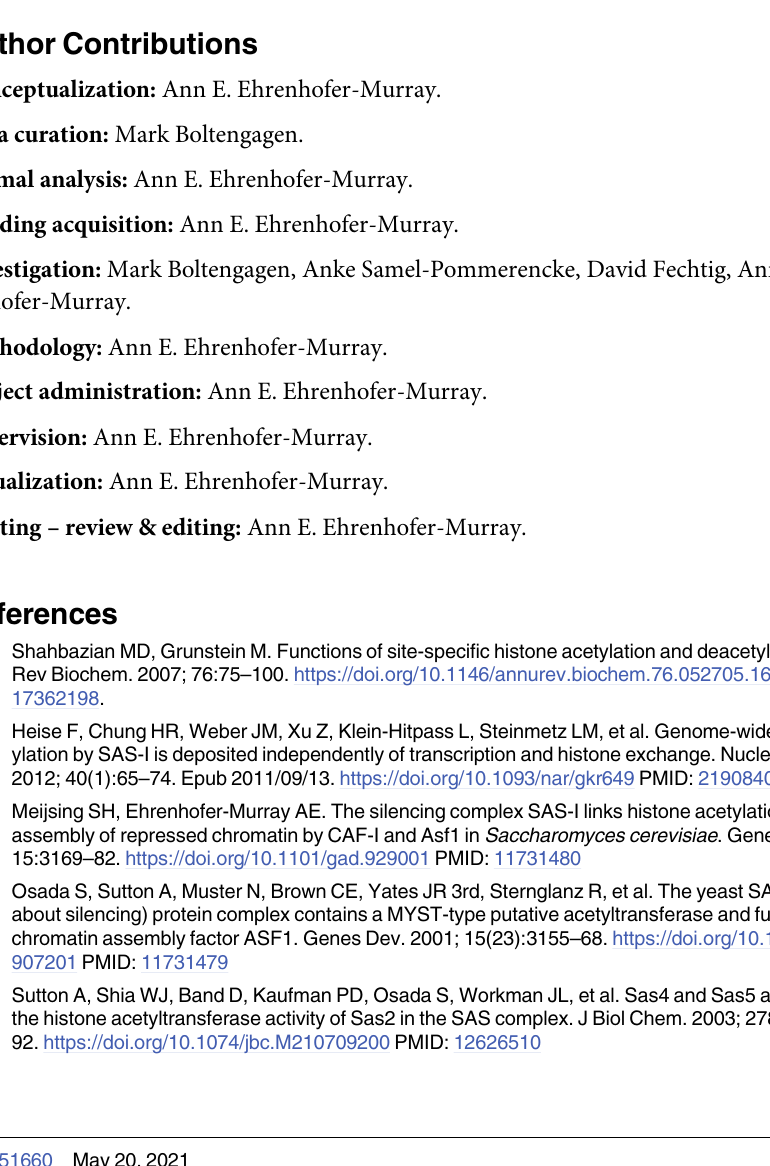
minutes) of yeast genes grouped by their length (bp). (E) Plot of gene length relative to the time of replication. (TIF) S3 Fig. H4 K16Ac levels in yeast strains lacking Sas2 and other histone acetyltransferases. Whole cell extracts of the indicated strains were analyzed by PAGE and Western blotting with α -H4 K16Ac (top) and α -H2B (bottom, loading control). H4 K16R, strain carrying H4 with a mutation of lysine 16 to arginine (control for antibody specificity). (TIF) S1 Raw images.